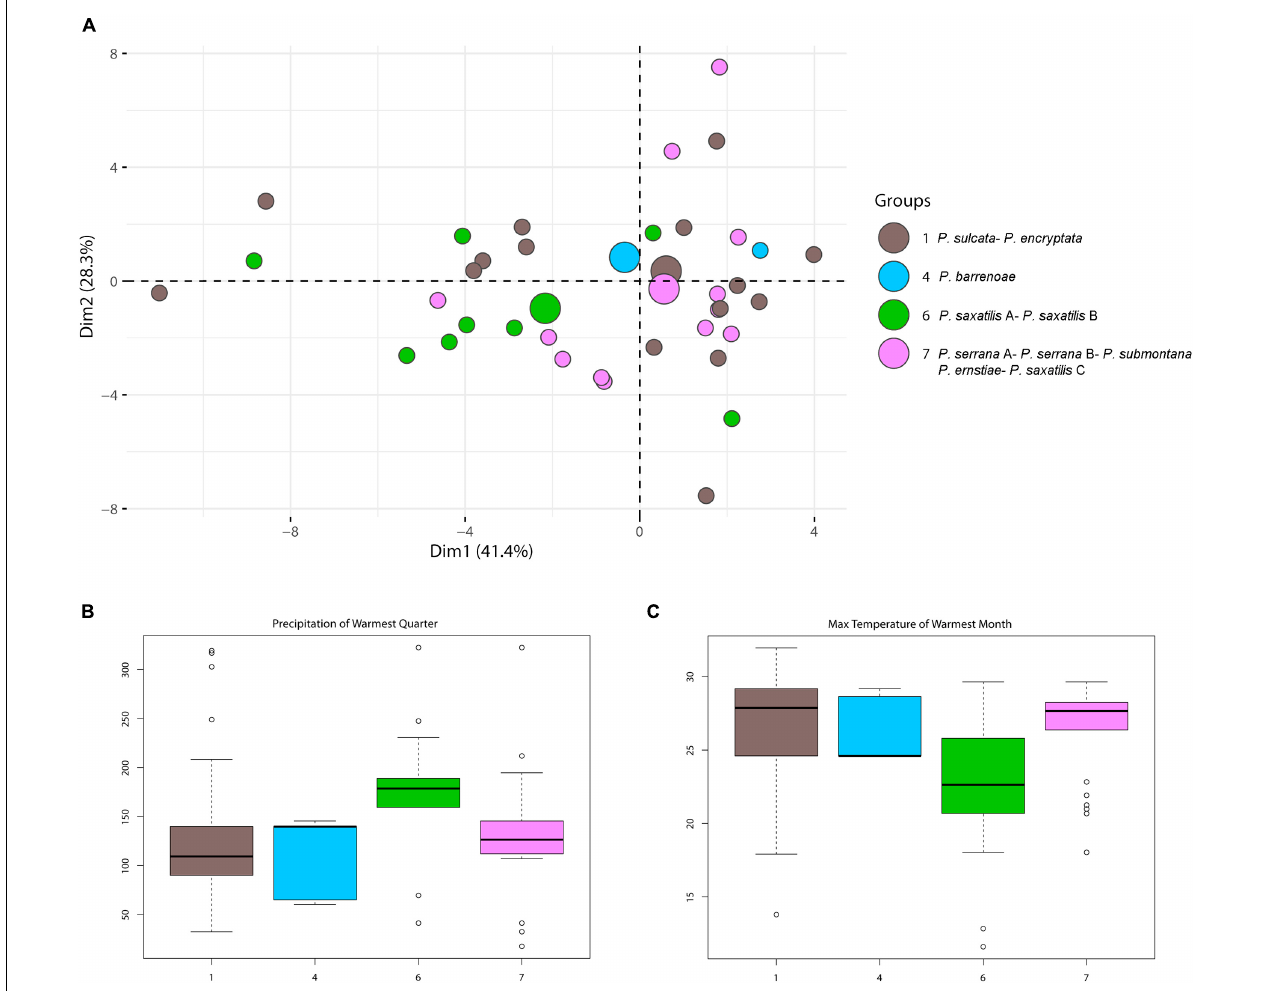
FIGURE 5 | (A) PCA result for modules 1, 4, 6, and 7 distributions depending on climatic factors. Large circles represent group centroids. (B,C) Box-plot diagram representing differences in climate preferences in selected modules 1, 4, 6, and 7. Climatic data were obtained from the Global Climate Data – WorldClim. (B) BIO5 = Max temperature of warmest month ( ◦ C) and (C) BIO18 = precipitation of warmest quarter ( ◦